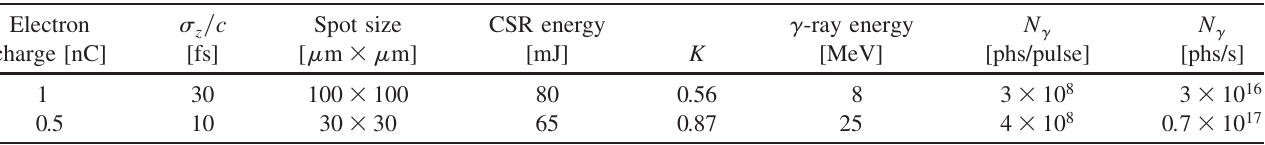
TABLE II. Optical cavity scheme in 5-GeV ERL: Horizontal acceptance angles are 12 mrad for (cid:2) ¼ 60 (cid:8) m and 9 mrad for (cid:2) ¼ 20 (cid:8) m for mode matching. Bandwidth of the on-axis (cid:1) ray is considered to be (cid:1) (cid:2) the (cid:1) ray is the same as (cid:3) z =c